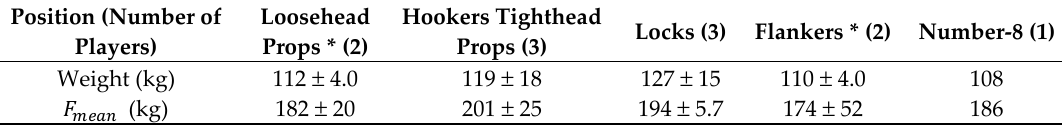
Table 2. Individual mean forces on the scrum machine.